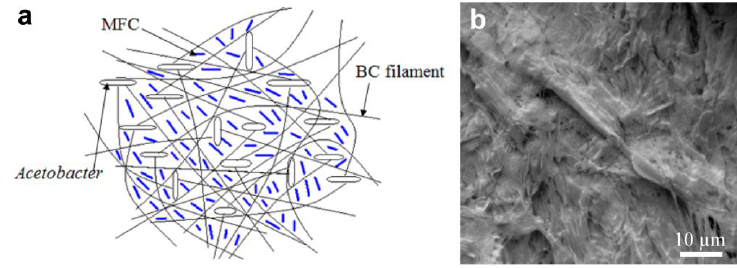
Figure 2. BC-MFC hybrid fibrous structure. Schematic of the BC-MFC hybrid ( a ) and a SEM image of the BC-MFC hybrid ( b ).